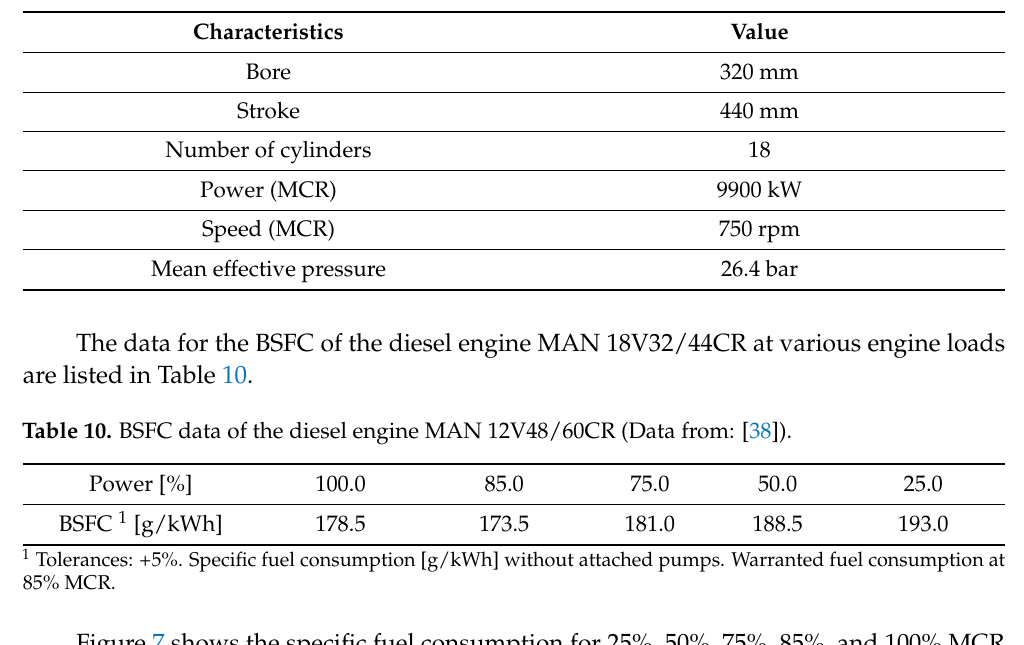
Figure 6. Propulsion with four medium-speed diesel engines (Legend: 1—propeller, 2—propeller